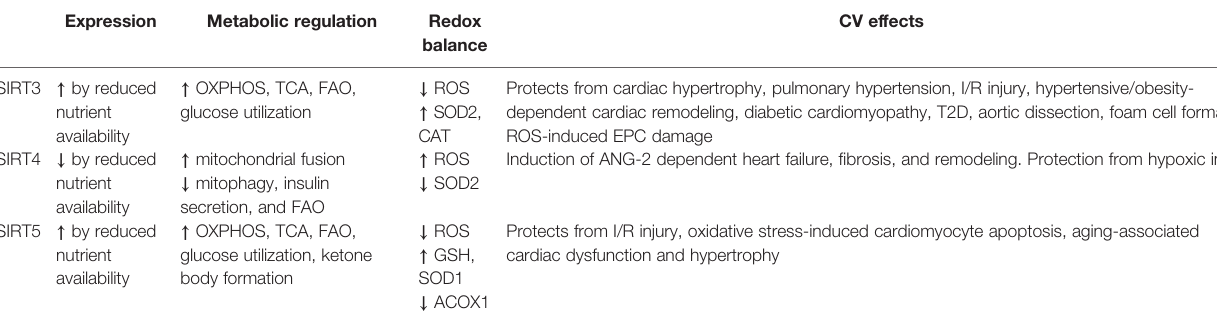
TABLE 1 | Main activities of mitochondrial sirtuins relating to metabolic regulation, redox balance and CVD.